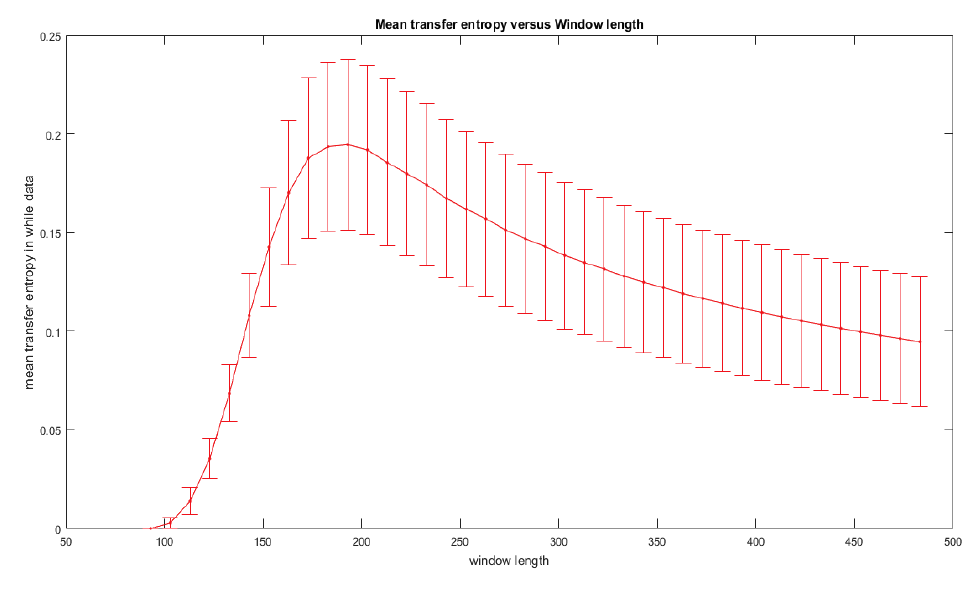
Figure 4. Average data transfer for 30 Dow Jones group